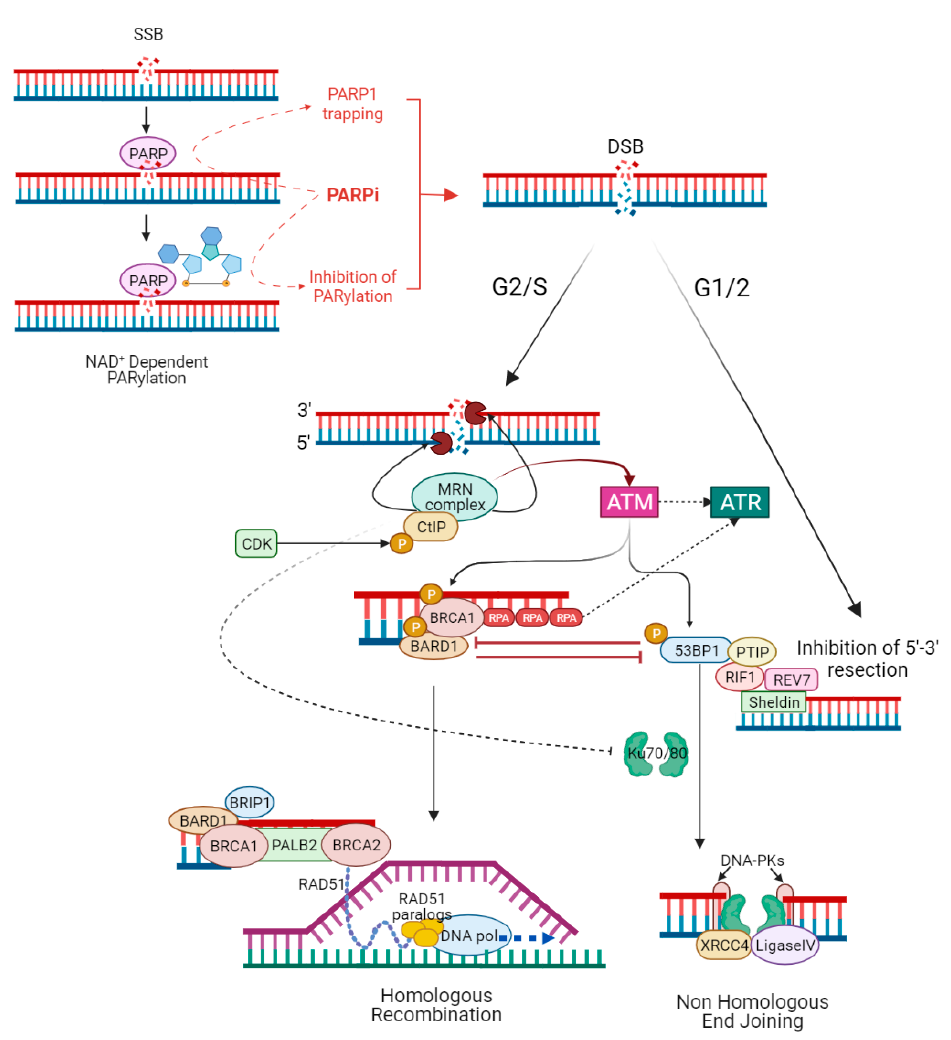
Figure 2. PARP inhibitors and the interactions between homologous recombination and non- homologous end joining. PARPi act mainly in a double way: inhibiting the catalytic activity of PARP1 (the so-called PARylation) and trapping PARP1 at sites of single-stranded DNA breaks (SSBs). In both cases, unrepaired SSBs lead to double-stranded DNA breaks (DSBs), which can be resolved mainly by HR or NHEJ. The choice between NHEJ and HR to repair DSBs is determined by several mechanisms, including activation of HR by cyclin-dependent kinase (CDK) activity (HR is restricted to G2/S phase when a homologous sister chromatid is available as template), or direct competition between HR and NHEJ stimulating factors at DSB sites. During G2/S, HR is activated by the binding of the MRN complex to DSB ends; MRN complex initiates DNA 5′ - 3′ end resection, leading to the formation of single-strand DNA (ssDNA) at the extremity of the DSB. CDK phos- phorylated CtIP binds MRN complex to facilitate end resection. The ssDNA is protected from deg- radation by the loading of replication protein A (RPA). The MRN complex recruits and activates the protein kinase ATM, while RPA finally drives ATR activation. ATM phosphorylated BRCA1– BARD1 complex interacts with the bridging protein PALB2, which in turn promotes the recruitment of BRCA2. PALB2 and BRCA2 remove RPA and facilitate the assembly of the RAD51 nucleoprotein filament. RAD51 nucleoprotein filament mediates the invasion of ssDNA into the intact sister chro- matid, searching for a homologous template for DNA synthesis and faithful repair of DNA. During G1/2, 5′ - 3′ end resection is suppressed and HR is inhibited due to lack of a sister chromatid. ATM phosphorylated 53BP1 binds and recruits RIF1 and PTIP that, together with the downstream effec- tors REV7 and Sheldin, inhibit 5′ - 3′ end resection and promote NHEJ. Ku70/80 heterodimer binds DSBs and recruits the DNA-dependent protein kinase catalytic subunit (DNA-PKcs) to form the